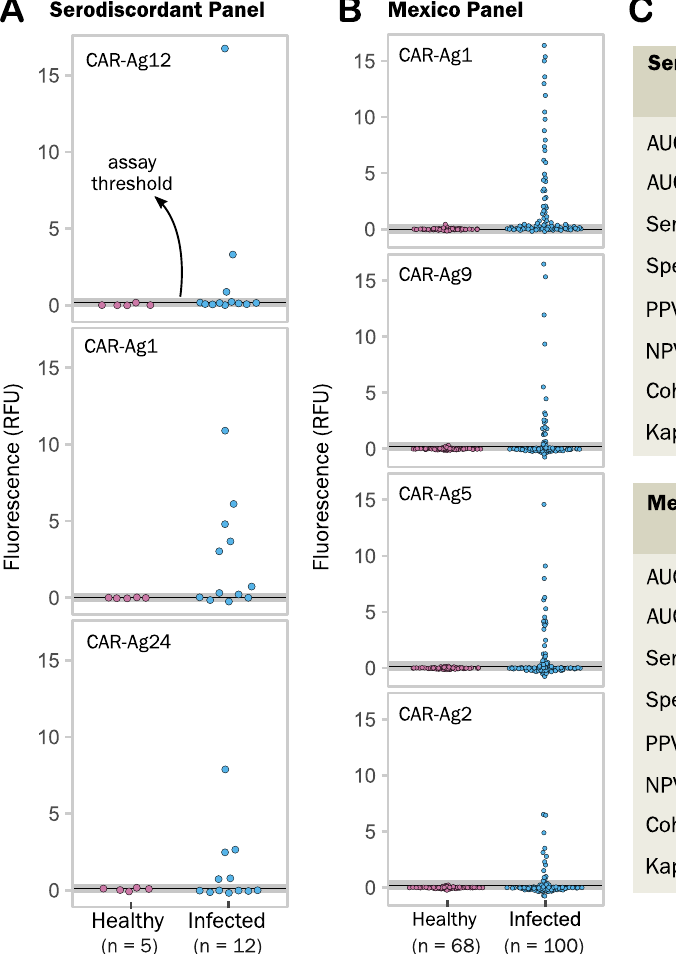
Fig.8|Performanceofidenti fi edantigensfordiagnosisofchallengingsamples. All assays are fl uorescent-linked immunosorbent assays (FLISA), each dot in a plot represents the average signal of duplicates from an individual sample. RFU means relative fl uorescence units. Assay threshold is shown as a black line and corresponds to the value of the mean signal of all healthy individuals plus three standarddeviations.Anindeterminatezonearoundthethresholdisshowningrey. A Reactivity of three antigens against a panel of serodiscordant individuals (see Methods);inthiscase,theclassi fi cationofHealthyvsInfectedisbasedontheresult